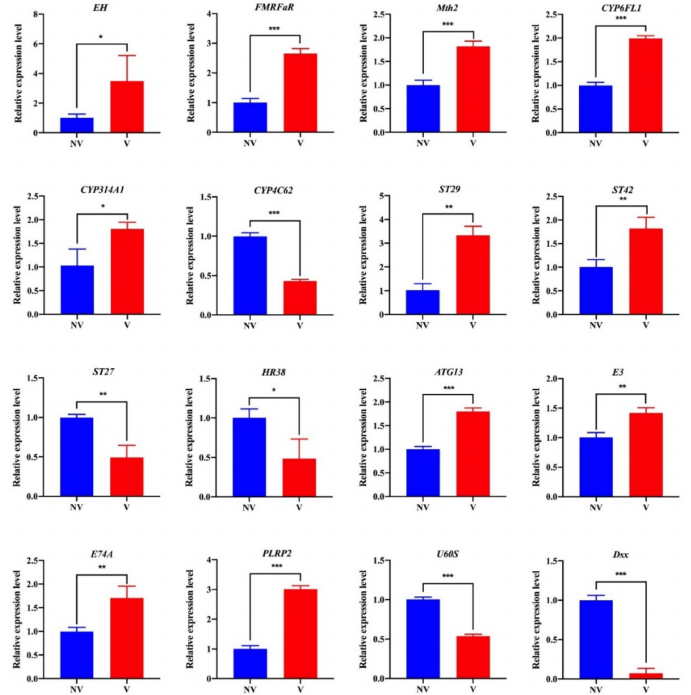
Figure 7. The expression levels of DEGs potentially associated with virus transmission were measured by qRT-PCR. NV represents the heads of non-viruliferous SBPHs, and V represents the heads of viruliferous SBPHs. Student’s t -test was used to determine the statistical differences between the samples. (* p < 0.05, ** p < 0.01, *** p <